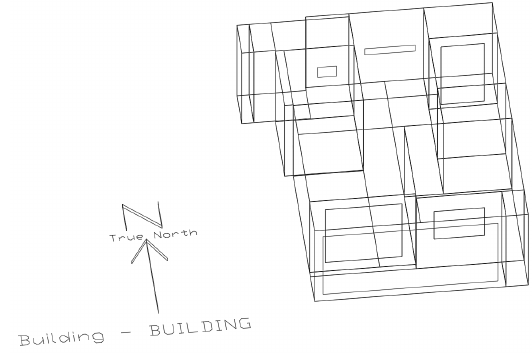
Figure 9. Simulation model of office building.